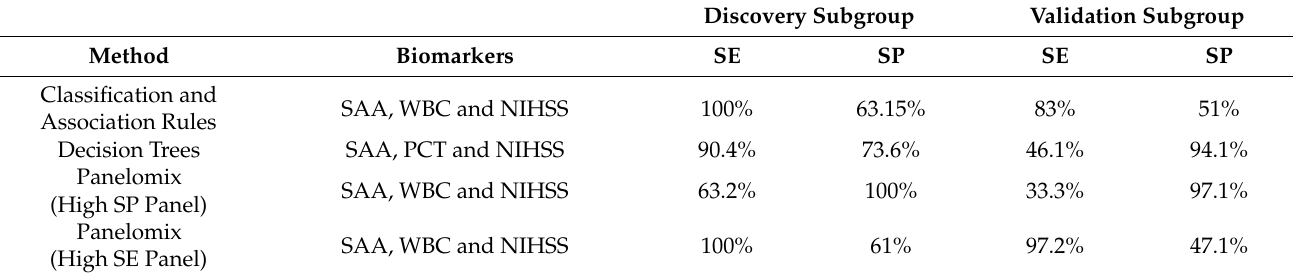
Table 6. Table summarizing performance and biomarkers for the three “white box”